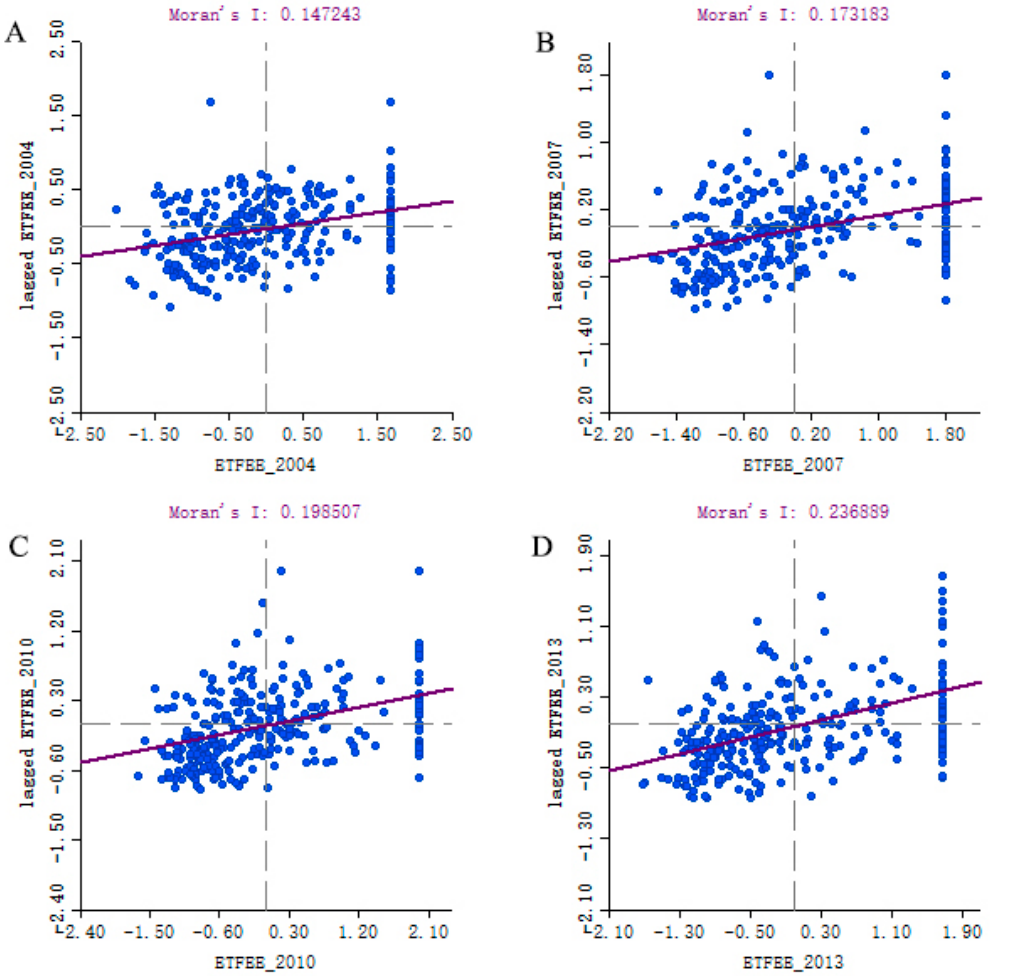
Figure 4. Scatter plots of Moran’s I for ETFEE in China’s prefecture-level cities. ( A ): Moran’s I for ETFEE in 2004; ( B ): Moran’s I for ETFEE in 2007; ( C ): Moran’s I for ETFEE in 2010; ( D ) Moran’s I for ETFEE in